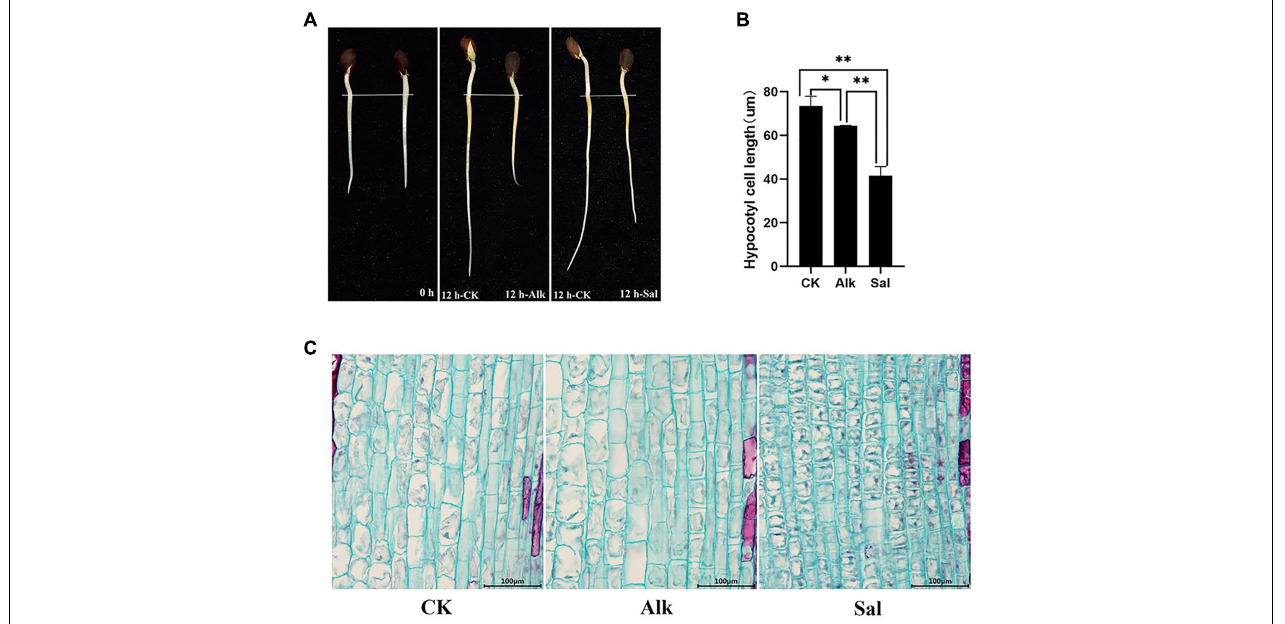
FIGURE 1 | The elongation characteristics of Gossypium barbadense hypocotyl cells under CK, Alk and Sal stresses. (A) The growth of G. barbadense hypocotyl under alkaline stress, from left to right are 0 and 12 h. (B) Statistics of the cell length of the three samples. Epidermal cell length was measured with the FcSnaP software and the lengths were averaged from at least 50 cells. The statistical significance of the measurements using one-way analysis of variance (ANOVA) was determined with test. The asterisk indicates the significant difference between the two stresses and the control group (* P < 0.05, ** P < 0.01). (C) Hypocotyl cell length under salt and alkaline stress, Scale bars, 100 µ